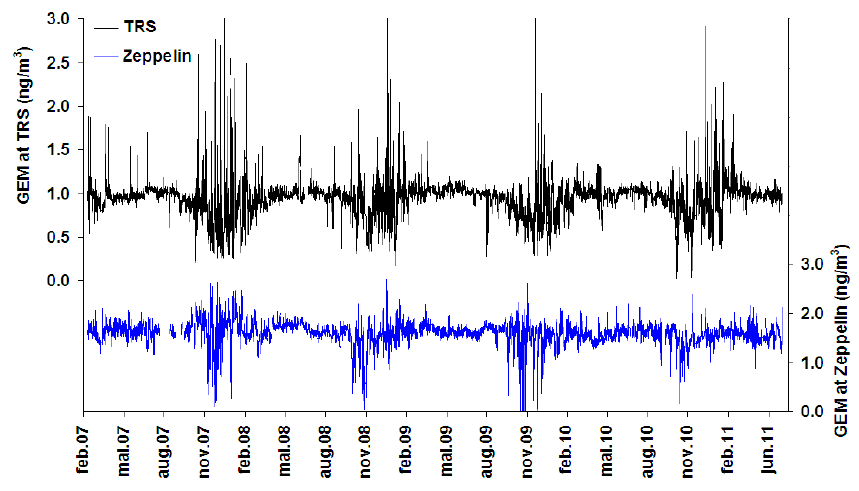
Fig. 4. Comparison of the time series of GEM concentrations from TRS in the Antarctic and Zeppelin in the Arctic. The time series from Zeppelin is shifted 182 days forward as compared to the TRS time series such that the seasons coincide.